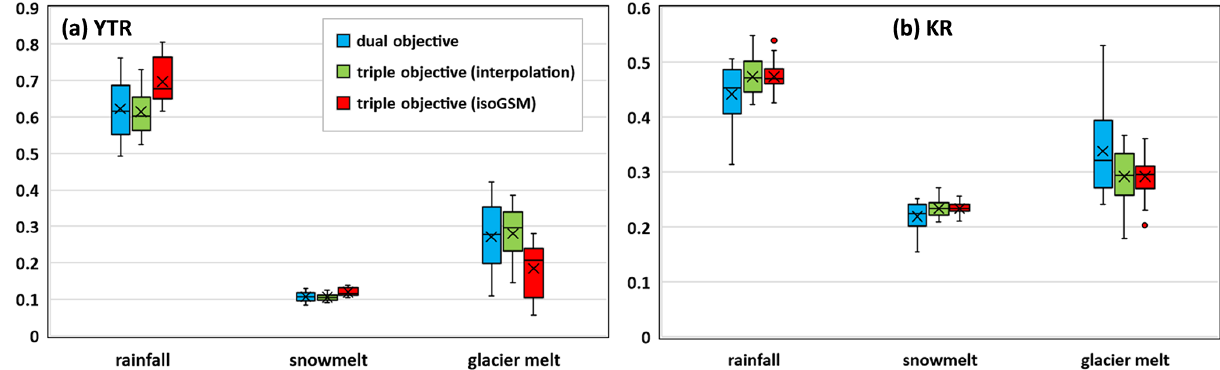
Figure 11. Average proportion and corresponding uncertainty ranges of different water sources in the annual water input for runoff generation estimated by different calibration variants in the (a) YTR and (b) KR